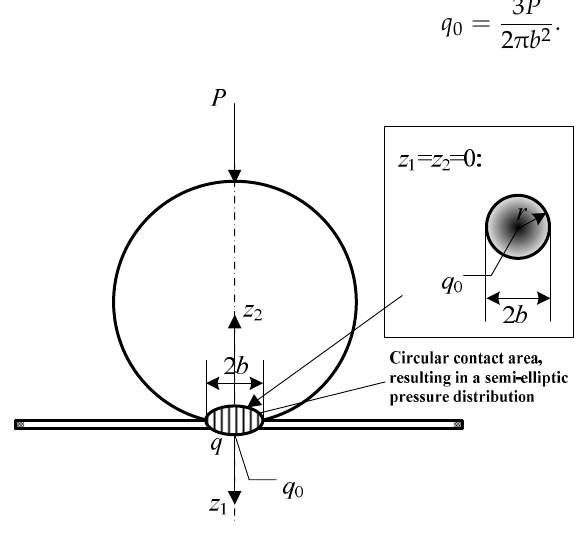
Figure 2. Contact area.